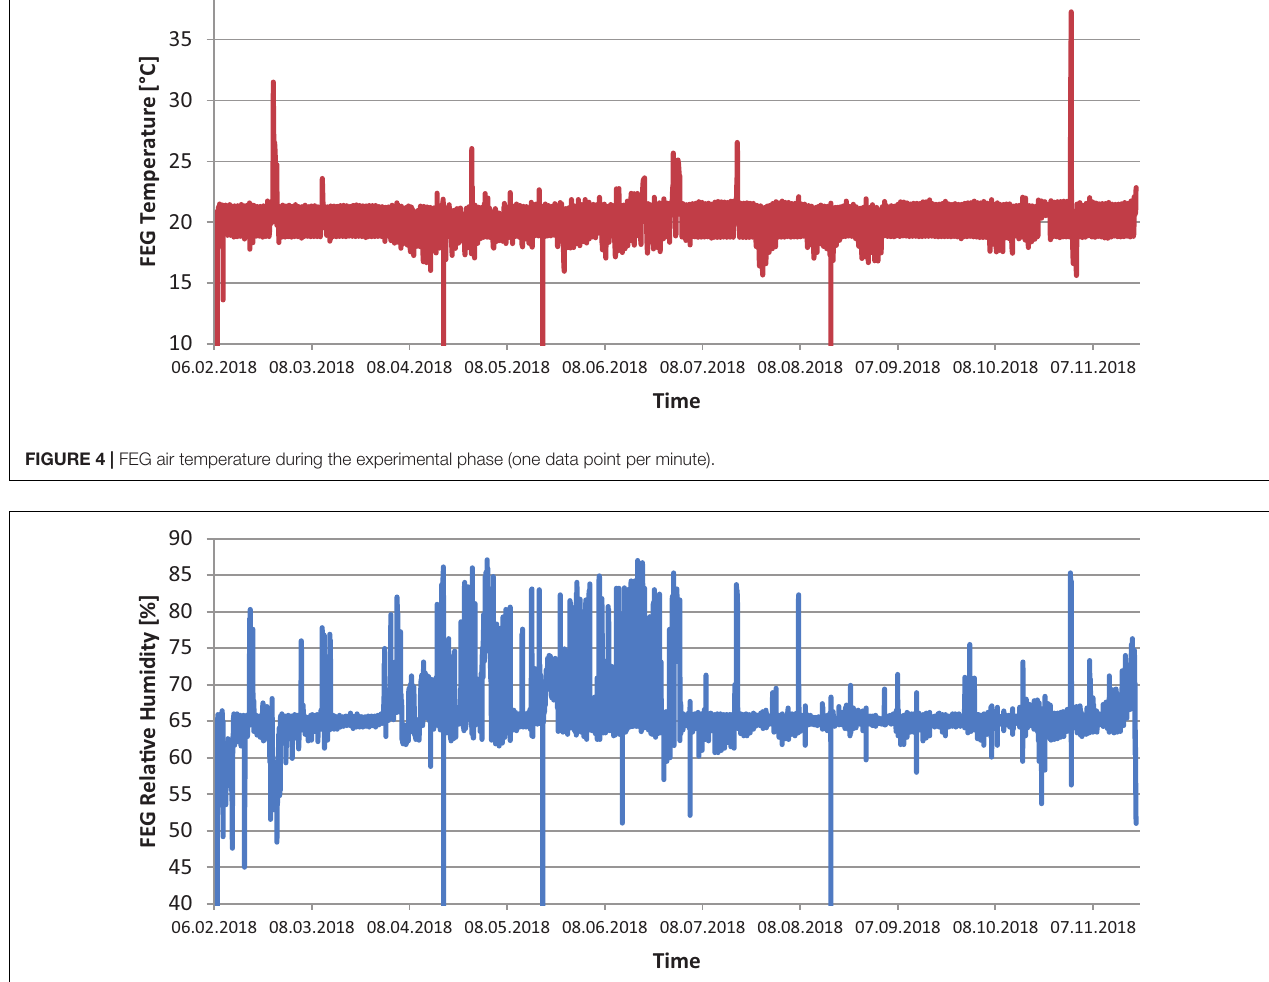
FIGURE 5 | FEG relative humidity during the experimental phase (one data point per